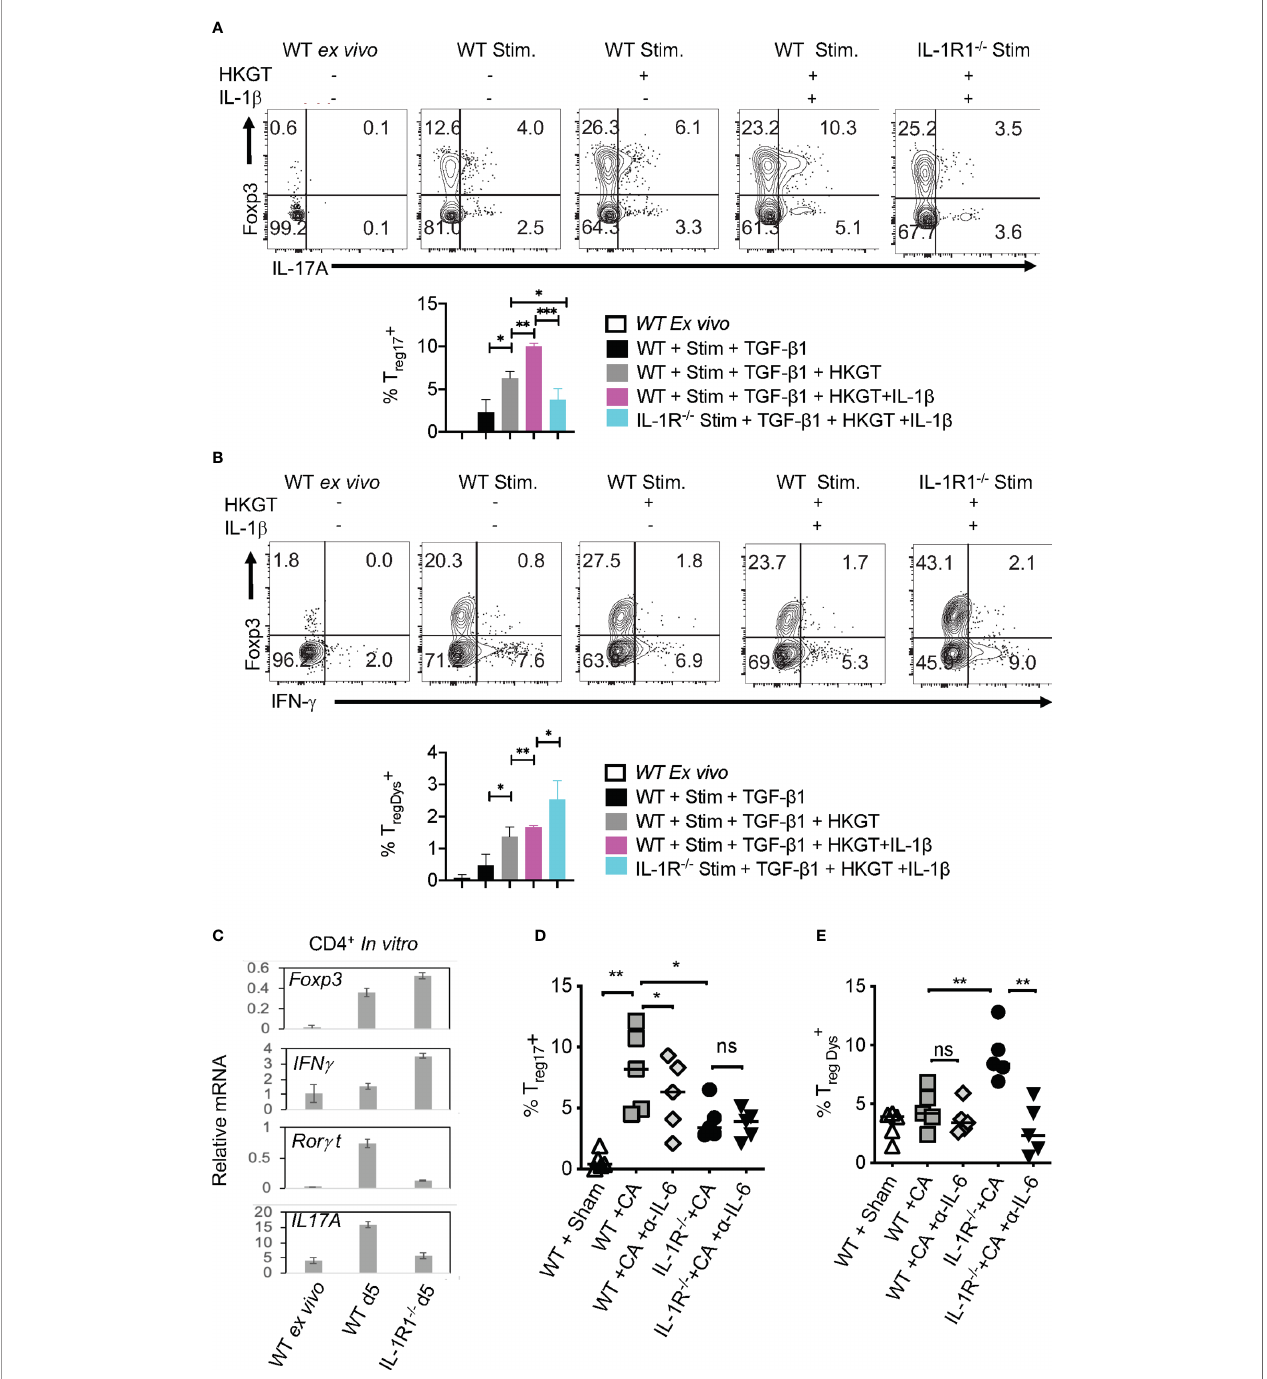
FIGURE 6 | Loss of endogenous IL-1R signaling diminishes T reg 17 but increases T regDys cells in CD4 + T cells in vitro . IL-6 expands T regDys cells in the absence of IL-1 b . Naïve CD4 + T cells from WT C57BL/6 and IL-1R (IL-1R1 -/- ) knockout mice were stimulated with heat killed Candida albicans germ tube (HKGT) and TGF- b 1 for 5 days as in Figure 1C with WT APC and stained for Foxp3, IL-17A ( A , top and bottom), and Foxp3 and IFN- g ( B , top and bottom) (gated on CD3 + CD4 + cells). (C) Naïve CD4 + T cells from WT C57BL/6 and IL-1R (IL-1R1 -/- ) knockout mice were stimulated with HKGT and TGF- b 1 for 3 days. CD4 T cells were puri fi ed from these cultures for qPCR assessment of indicated transcripts. (D, E) WT and IL-1R1 -/- mice were orally infected with CA, and cervical lymph nodes (CLN) and mouse oral intra-epithelial and lamina propria leukocytes (MOIL) were collected 3 days after infection (n=5/group) for HKGT restimulation for 2 days and fl ow cytometry. Statistical analyses of Foxp3 + ROR- g t + IL-17A + (D) , and Foxp3 + IFN- g + (E) , expressing cells after PMA/Iono restimulation for 4 h in vitro (gated on CD3 + CD4 + cells). a - IL-6 antibody (10 m g/ml) was added in some cultures. Data are representative of at least 3 independent experiments. NS, non-signi fi cant. *P < 0.05, **P < 0.005, ***P <